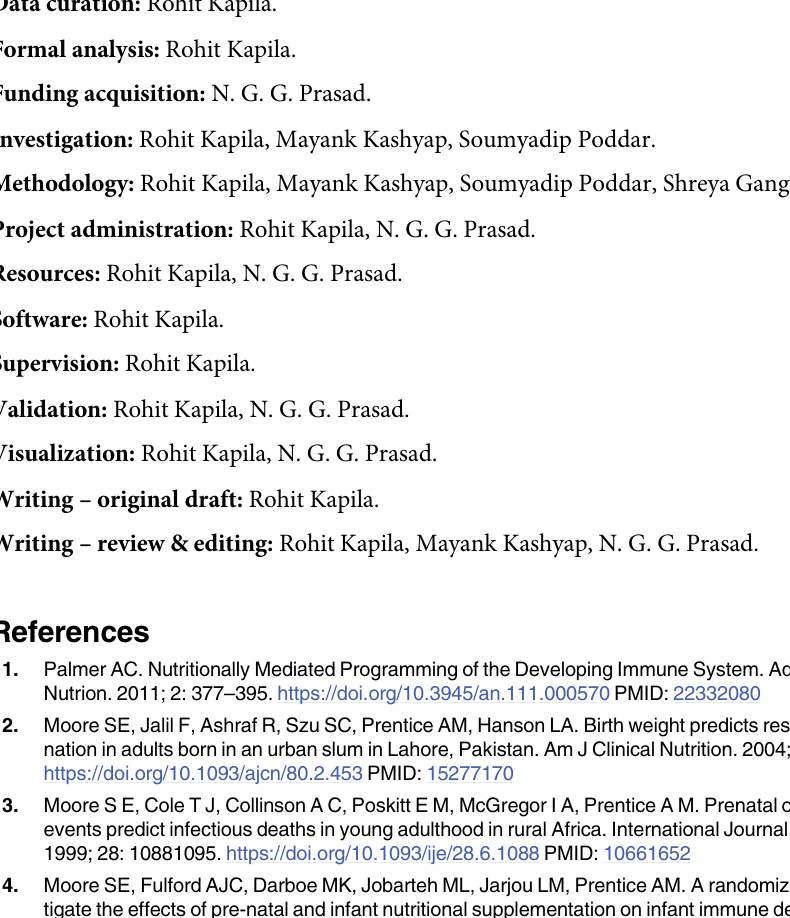
S9 Table. Logistic regression of females alive at the end of the observation period against P . entomophila . S10 Table. Survivorship data against Pseudomonas entomophila bacteria with time of death in hours post infection. S11 Table. Survivorship data against Enterococcus faecalis bacteria with time of death in hours post